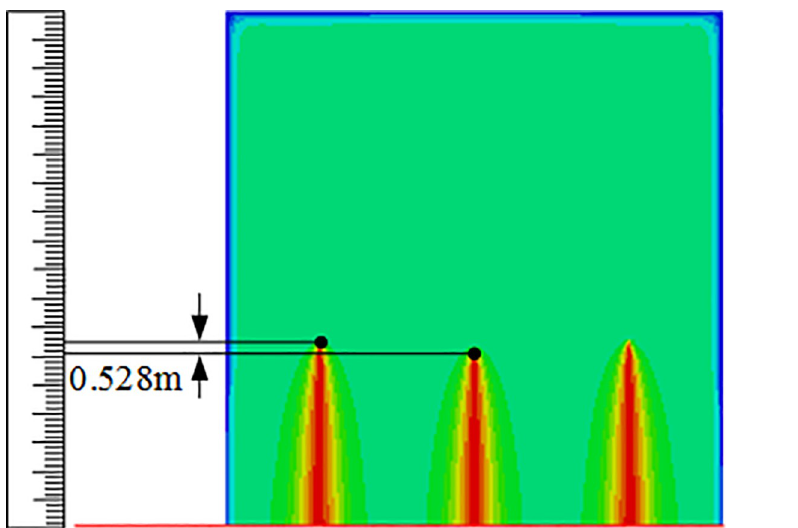
Fig 18. Crack propagation shape after